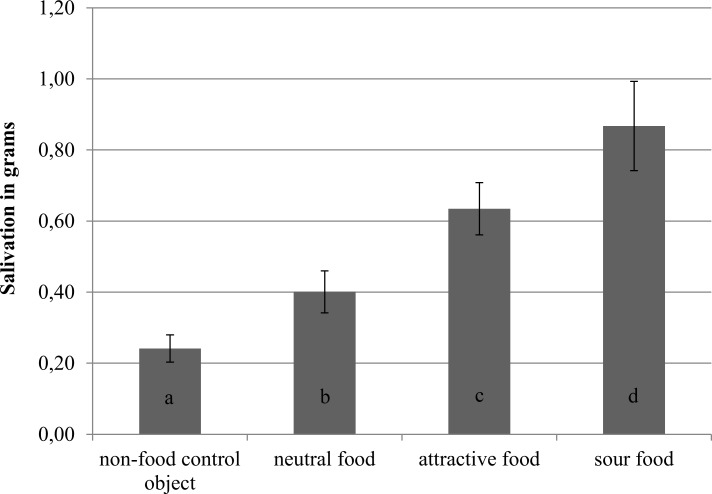
Salivation in response to stimulus exposure and simulating its consumption in Experiment 1.Different letters indicate significant differences between objects, p < .05. Error bars represent standard errors from the mean.